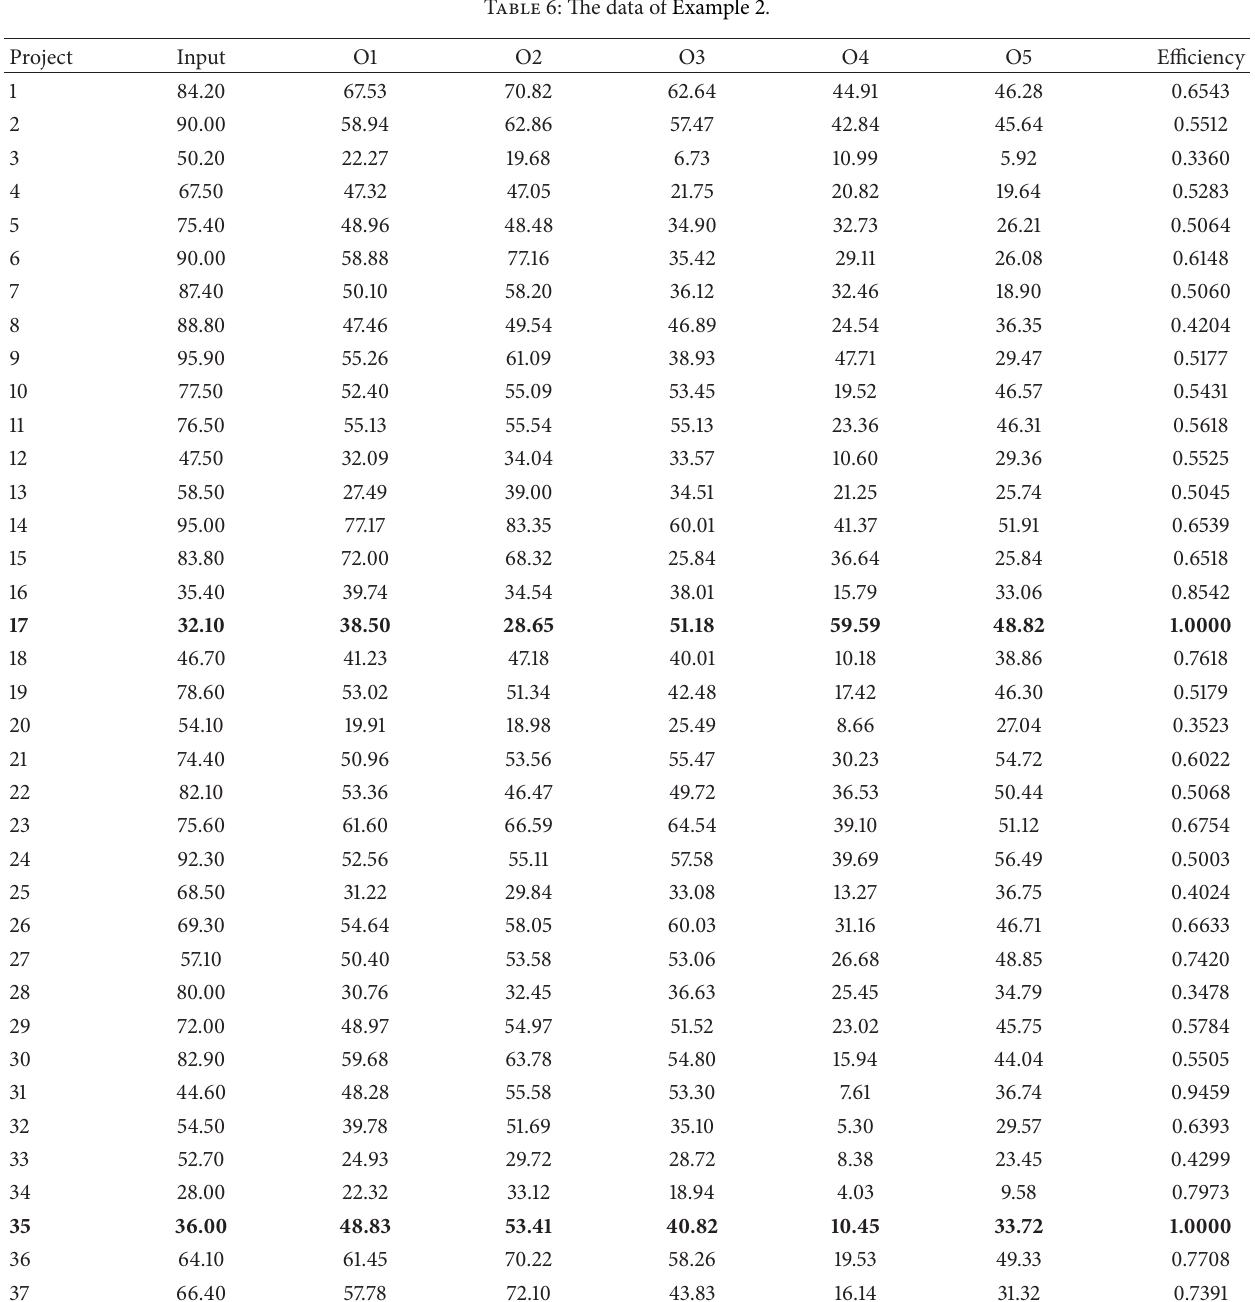
Table 6: The data of Example